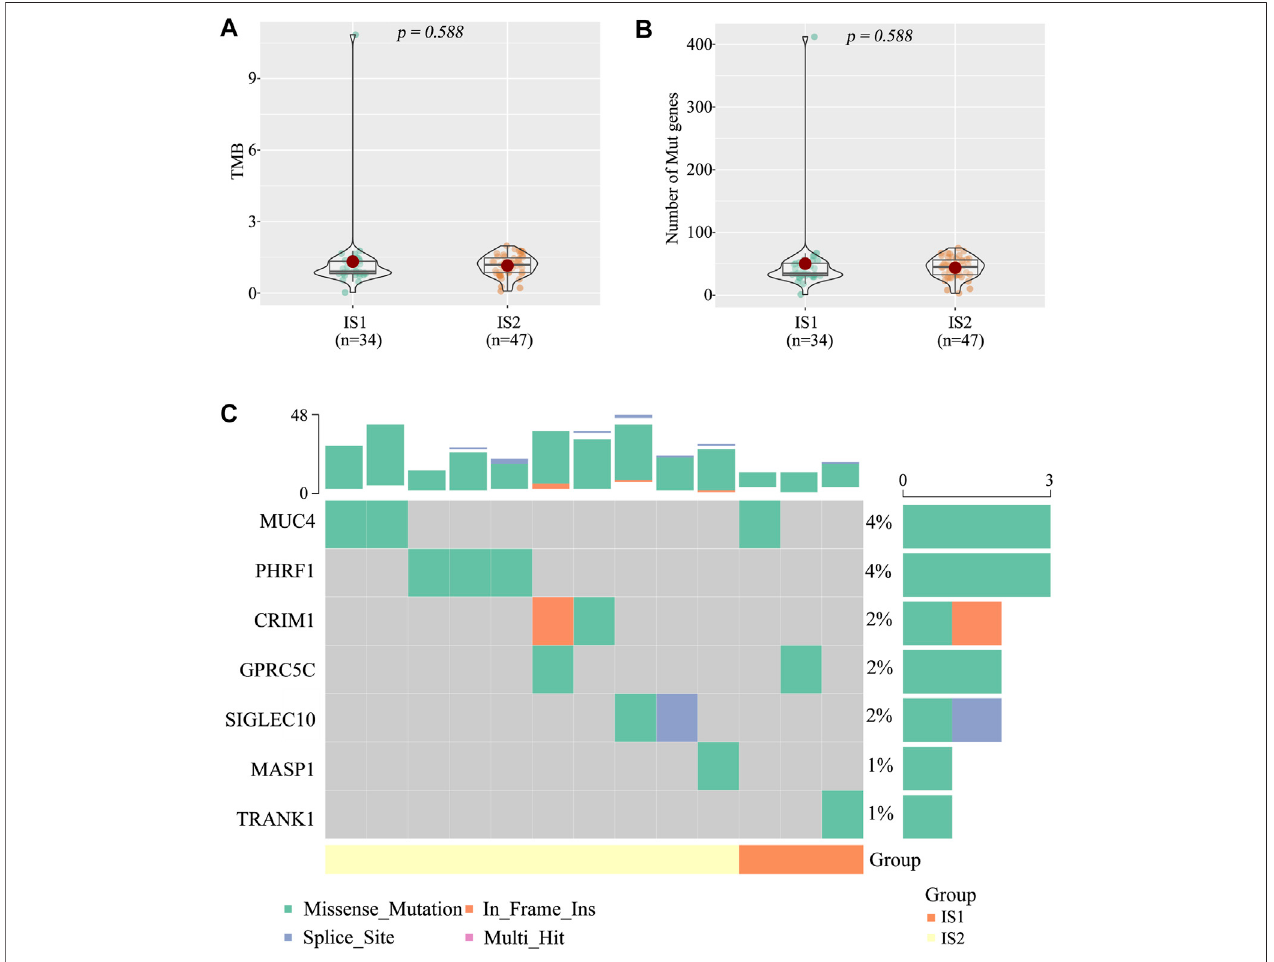
FIGURE 5 | The tumor mutational burden (TMB) between the two immune subtypes (A) TMB (B) Number of gene mutations (C) Seven high mutation genes in the two immune subtypes.